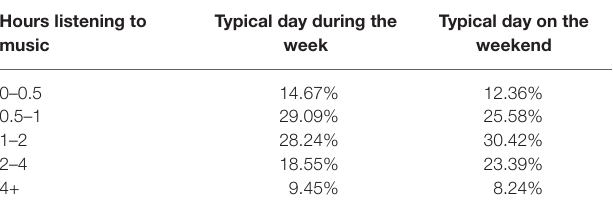
TABLE 1 | Hours of listening to music during the week and on the weekend.